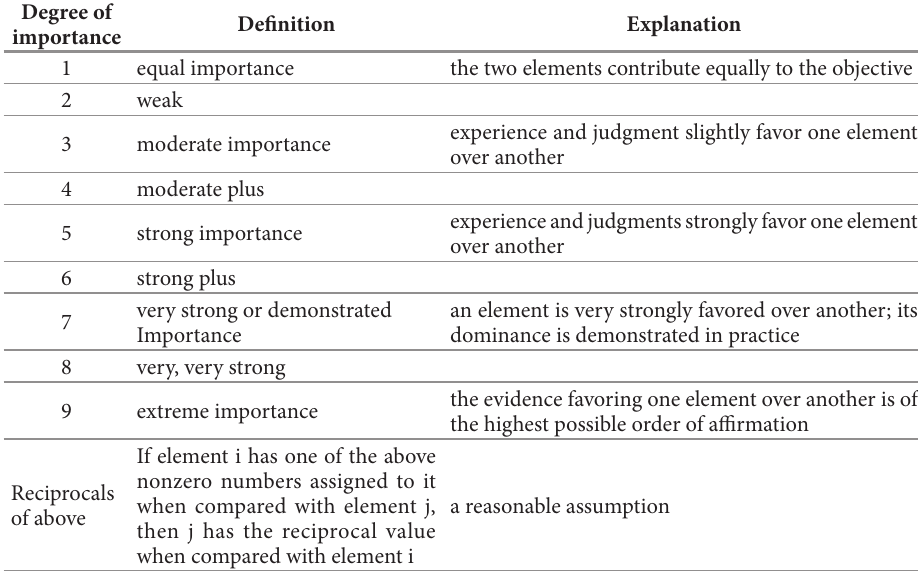
Table 1. Saaty’s fundamental comparison scale Degree of